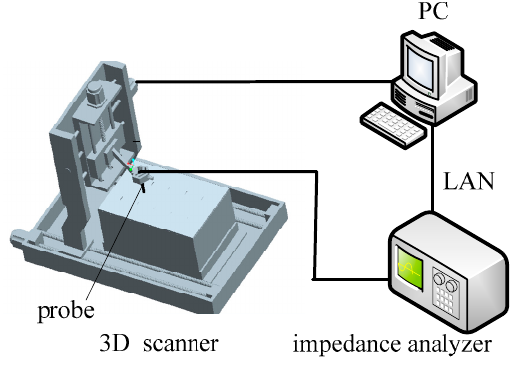
Figure 1. Automated experimental setup.